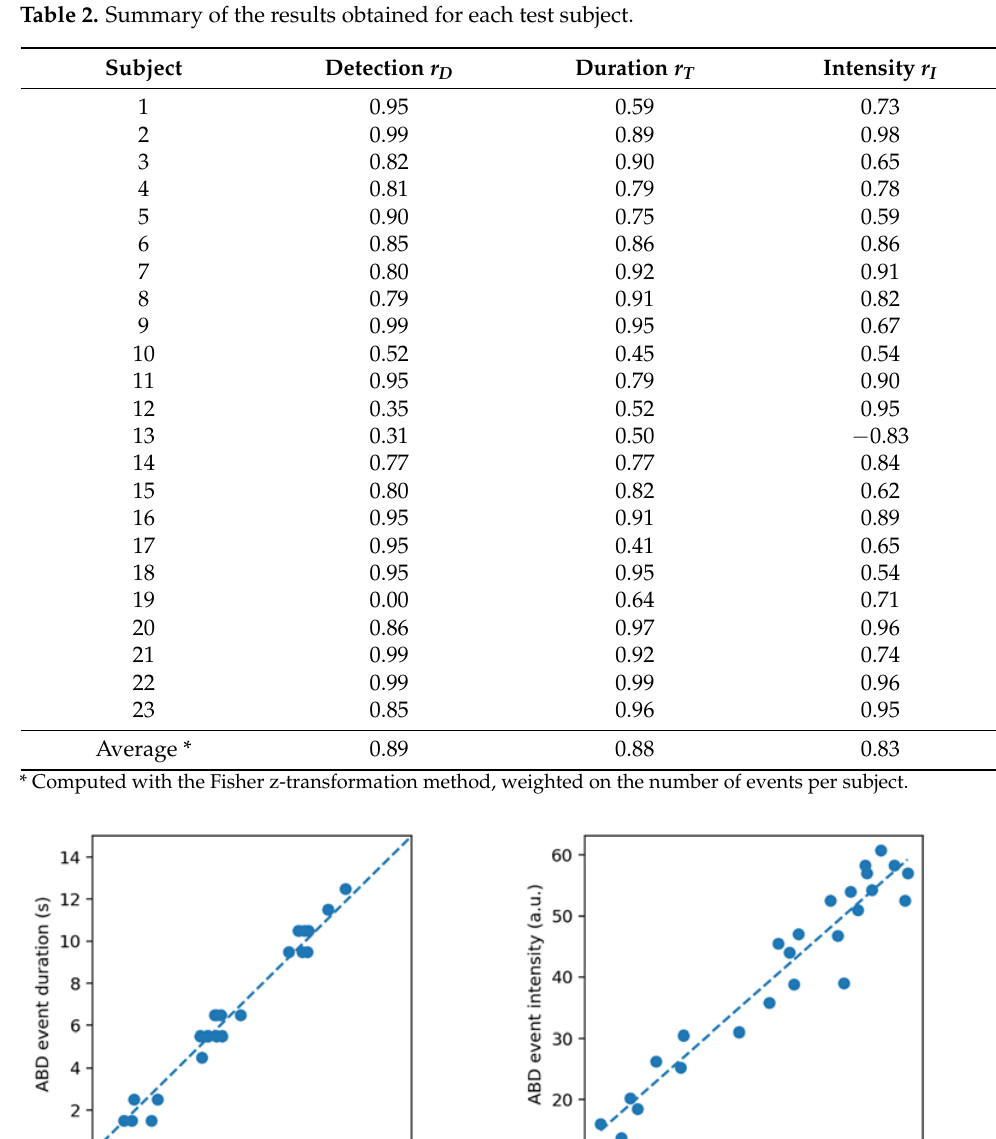
Table 2. Summary of the results obtained for each test subject.